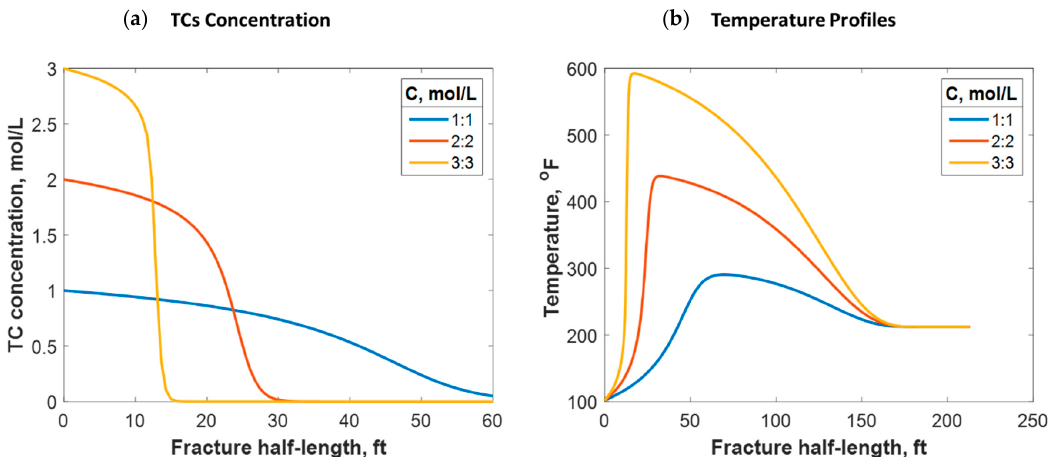
Figure 15. ( a ) TC concentrations and ( b ) fluid temperature profiles along the fracture half-length at different TC concentration values.